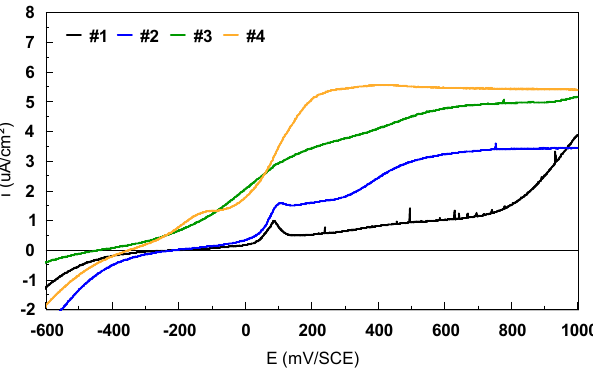
Figure 15. Potentiodynamic polarization curves recorded in 9 g/L NaCl electrolyte for the bulk Ti-based alloys (linear scale).